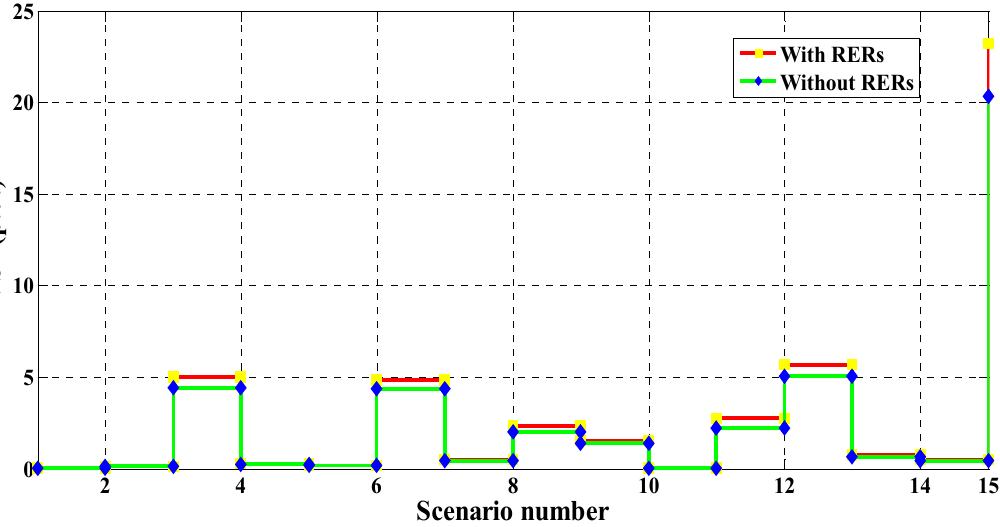
Figure 17. The 51-bus system VSIs.